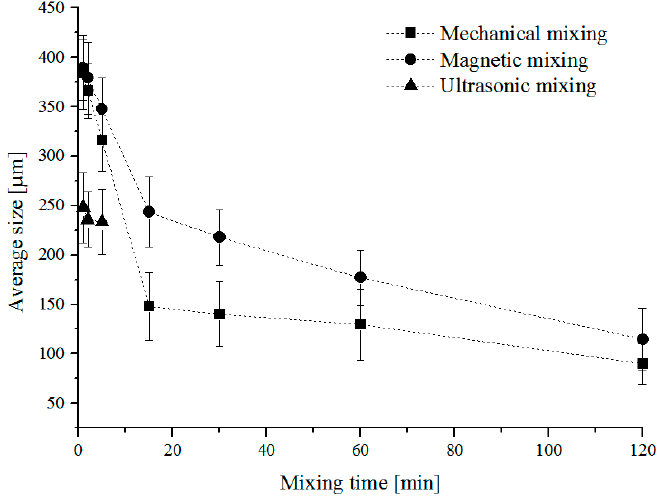
Figure 4. Average size of RP as a function of mixing time and methods.